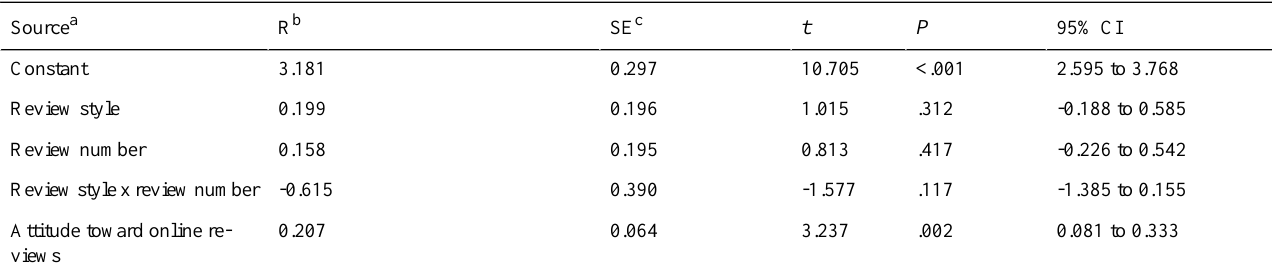
Table 3. Results of the moderated mediation analyses for the outcome variable, perceived trustworthiness of the